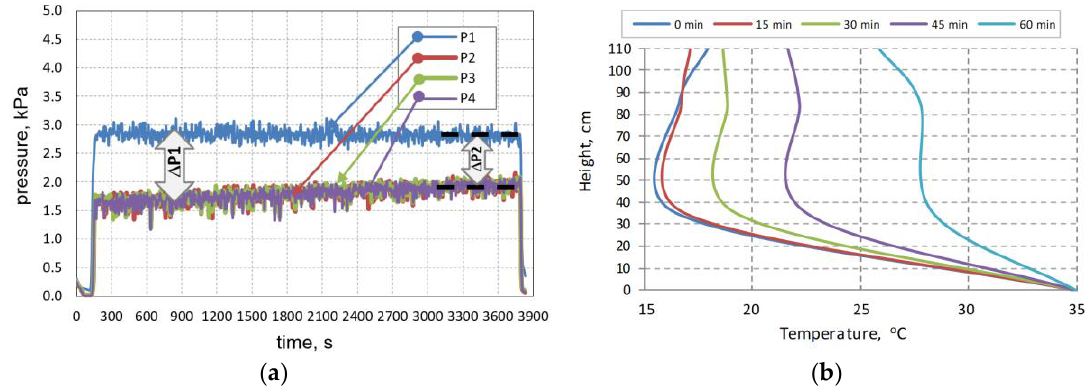
Figure 5. Sample test results for 3D installation filled with Bełchatów brown coal, grain size 0–8 mm: ( a ) air pressure during the coal drying process; ( b ) the distribution of the air temperature in the fluidization chamber during the coal drying process.